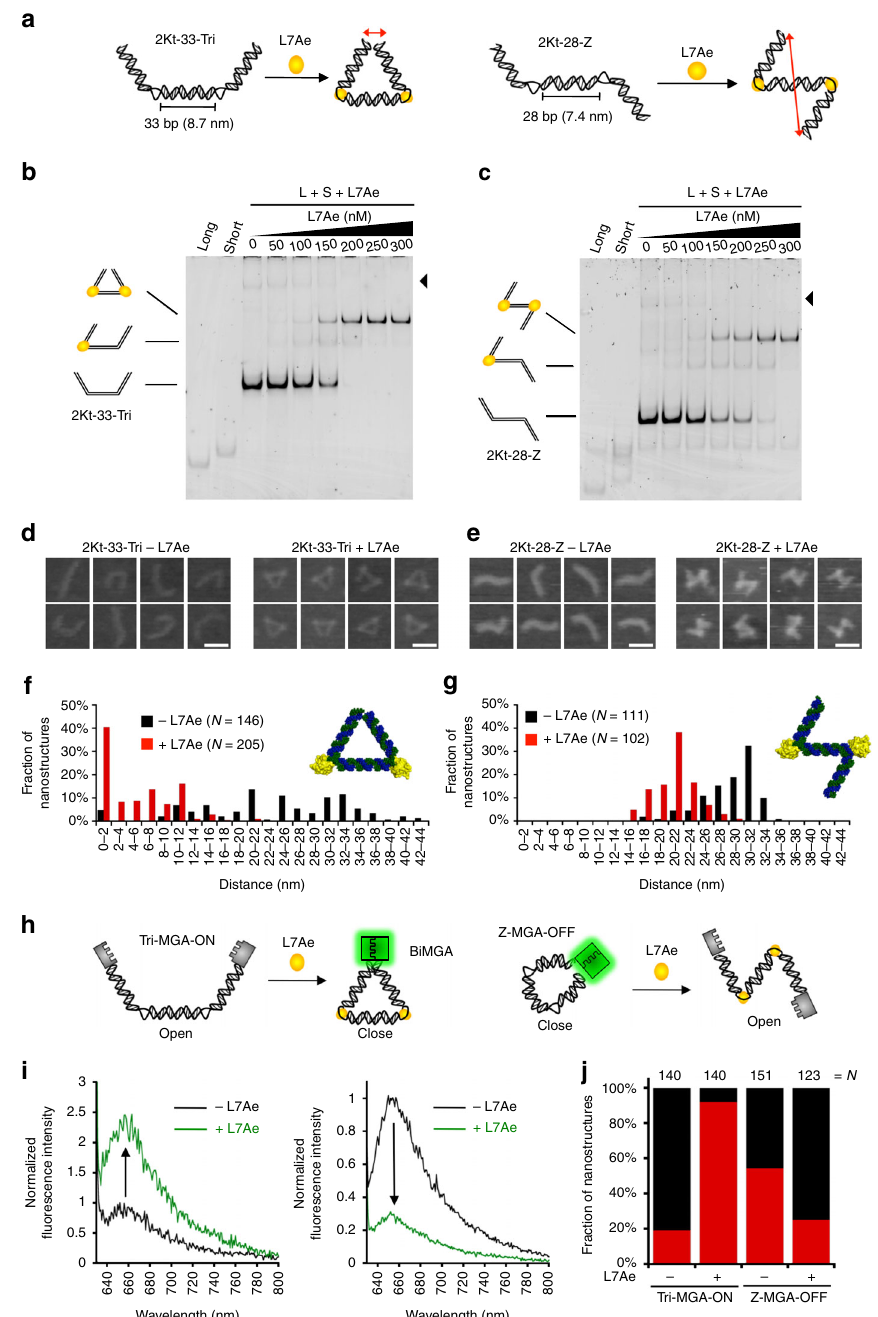
Fig. 2 Actuation of protein-driven RNA nanodevices in vitro. a Schematic representation of structural changes in 2Kt-33-Tri ( left ) and 2Kt-28-Z ( right ) caused by the induced- fi t of RNA in response to L7Ae binding. The distance between the two ends of the RNA is indicated by a red double-headed arrows. The in silico predicted lengths of each side of 2Kt-33-Tri and 2Kt-28-Z were ~8.7 nm and 7.4 nm, respectively. b , c EMSA con fi rmed the interaction between 2Kt-33-Tri ( b ) and 2Kt-28-Z ( c ) RNA nanostructures with L7Ae. Higher order bands ( black arrowheads ) indicate heterogeneous oligomers composed of L- and S-RNA strands. Concentrations of long and short RNAs: each 50 nM. d , e AFM images of the 2Kt-33-Tri ( d ) and 2Kt-28-Z ( e ) RNA nanostructures in the absence ( left ) and presence ( right ) of L7Ae. Scale bars , 20 nm. f , g Statistical distribution of the distance between the two ends of RNA, indicated by the double-headed arrows in a , for 2Kt-33-Tri ( f ) and 2Kt-28-Z RNA ( g ) nanostructures in the absence ( black ) and presence ( red ) of L7Ae ( N number of nanostructures). h Schematic illustration of the ON/OFF switching of biMGA activity caused by structural changes in RNA nanodevices in response to L7Ae binding. Fluorescence emission of Tri-MGA-ON is caused by the formation of an active biMGA that occurs with a L7Ae-induced RNA conformational change that places two split aptamers close to each other ( left ). Fluorescence quenching of Z-MGA-OFF is caused by disassembly of the biMGA that occurs with a L7Ae-induced conformational change that separates the two split aptamers ( right ). i Fluorescence spectra of Tri-MGA-ON ( left ) and Z-MGA-OFF ( right ) in the absence ( black ) and presence ( green ) of L7Ae. j Fraction of open ( black ) and closed ( red ) nanostructures before and after RNP formation ( N number of nanostructures). Tri-MGA-ON: Tri-MGA-ON-stem B (Supplementary Fig. 10). Z-MGA-OFF: Z-MGA-OFF-stem D (Supplementary Fig.